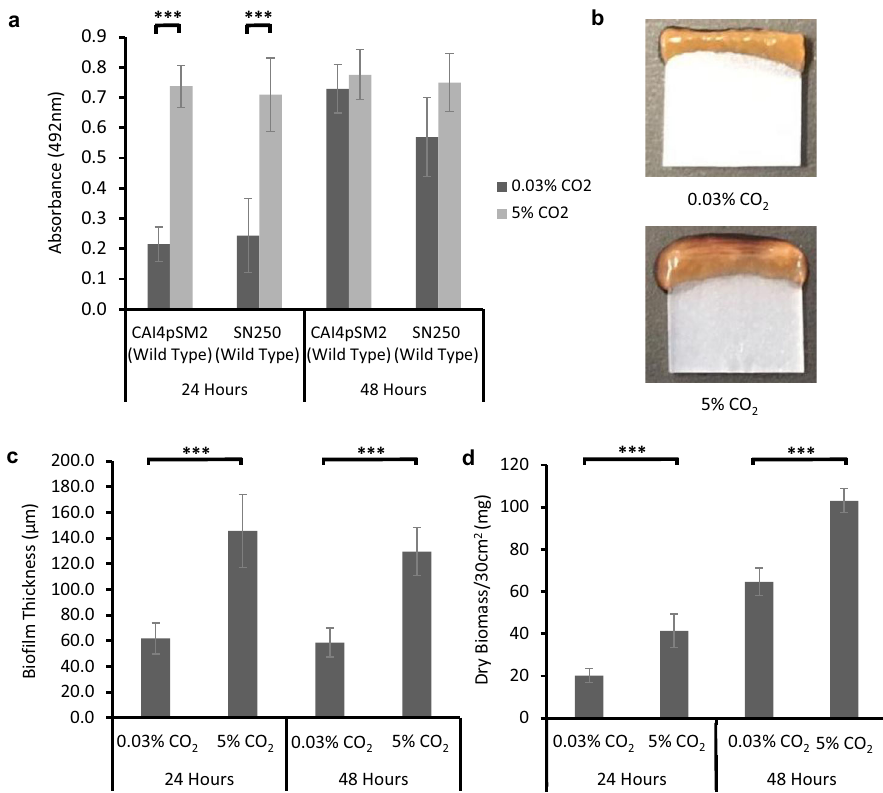
Fig. 1 The effect of high CO 2 (5%) on C. albicans bio fi lm formation. a Reference strain bio fi lms were seeded and grown for 24 or 48 h in 0.03% or 5% CO 2 ; the resulting bio fi lms were quanti fi ed using the XTT assay with absorbance at 492 nm as a readout. b Representative images of C. albicans (SN250 strain) bio fi lms grown in 0.03% and 5% CO 2 for 48 h (red colouration due to XTT assay). c SN250 bio fi lms were seeded on chamber slides and grown for 24 or 48 h in 0.03% or 5% CO 2 before staining with SPYRO Ruby bio fi lm matrix stain. Z -stacks were taken using ×20 objective magni fi cation and bio fi lm thickness was quanti fi ed. Graphs represent three biological replicates, error bars denote standard deviation. Paired two-tail t tests were carried out: *** p < 0.001, n.s. = not signi fi